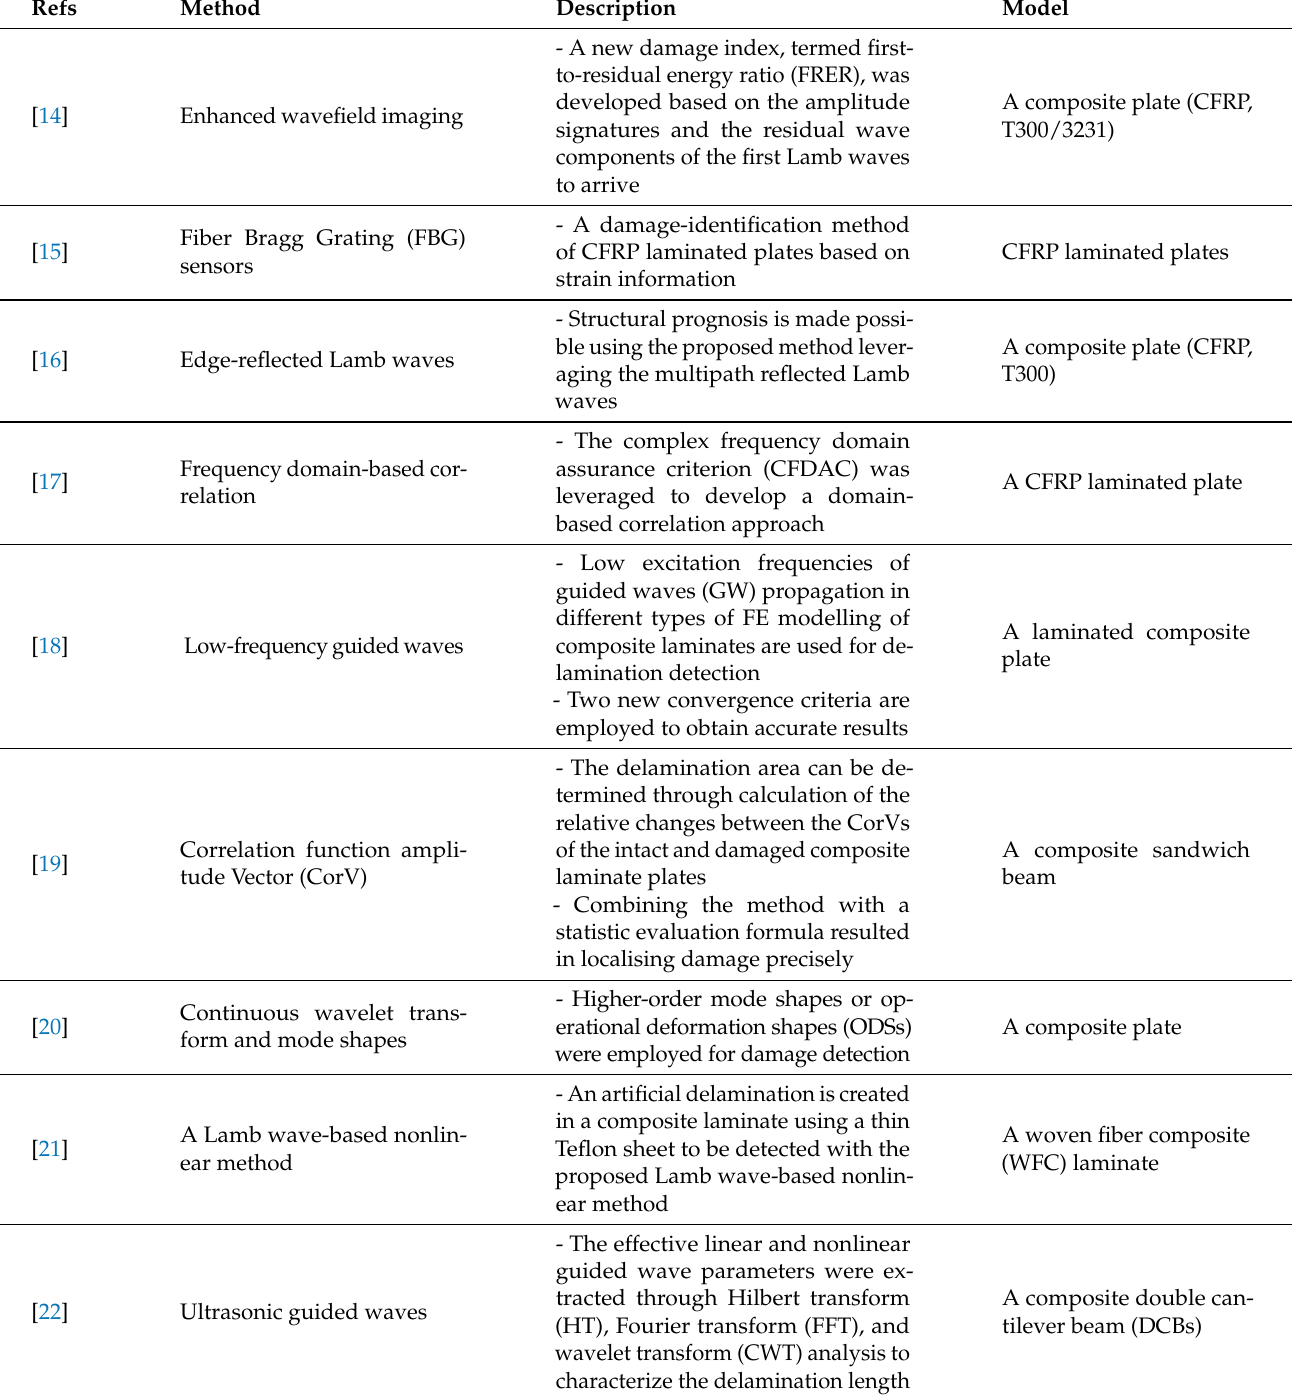
Table 1. Some recent advancements in SHM of composite